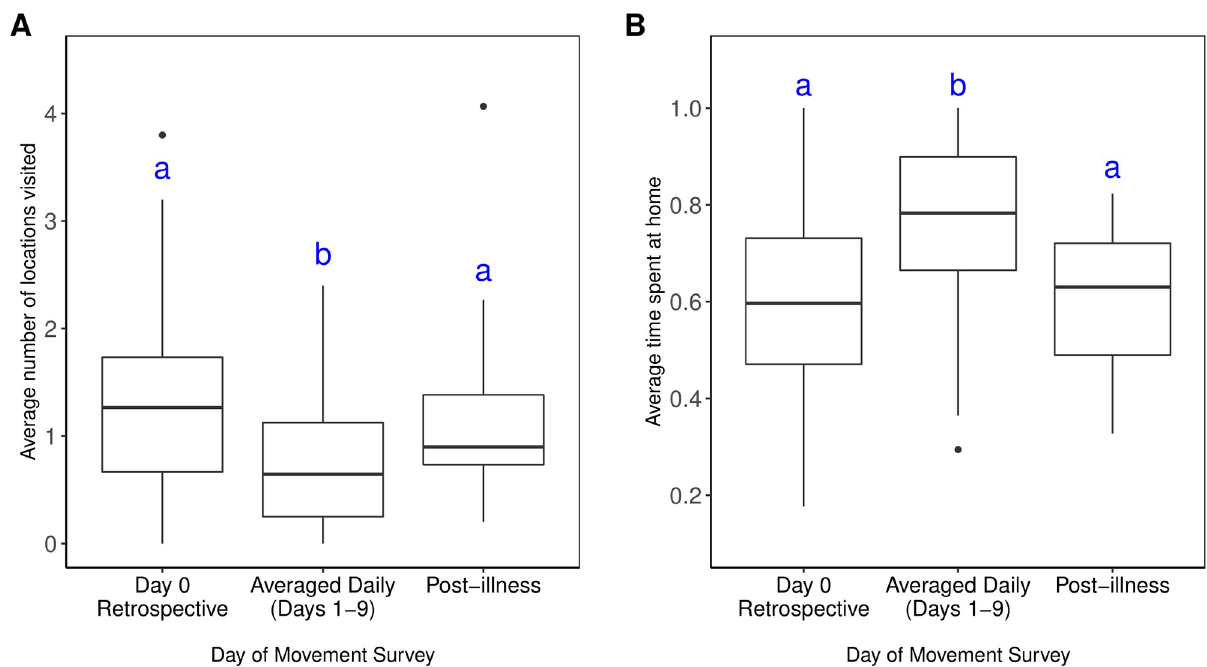
Fig 1. Mobility values throughout illness. (A) Average number of locations visited during each time period (B) Average proportion of time spent at home during each time period. Significant differences, denoted by letters, were detected using pairwise paired Wilcoxon Sign Rank tests with Bonferroni’s correction to account for a family-wise error-rate of 0.05. All significant differences had p-values < 0.01.